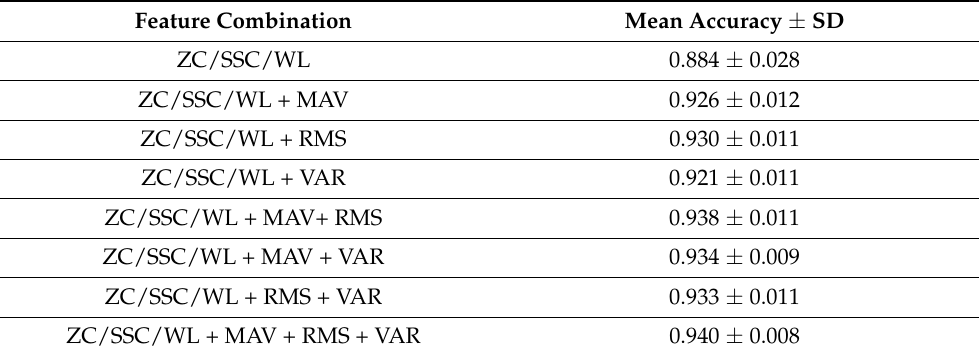
Figure 10. Box plots comparing accuracy of ANN-based classifiers according to feature combinations. The plot shows the median (thick line in the box), interquartile range (the box), range (whiskers), and accuracies obtained from each subject (black dots). The effect of the feature combination on the accuracy was significant ( p < 0.001, one-way ANOVA). Lines above the box plots display post-hoc comparisons between feature combinations conducted using the Games–Howell method ( * p < 0.05). Table 5. Accuracy of ANN-based classifiers according to feature